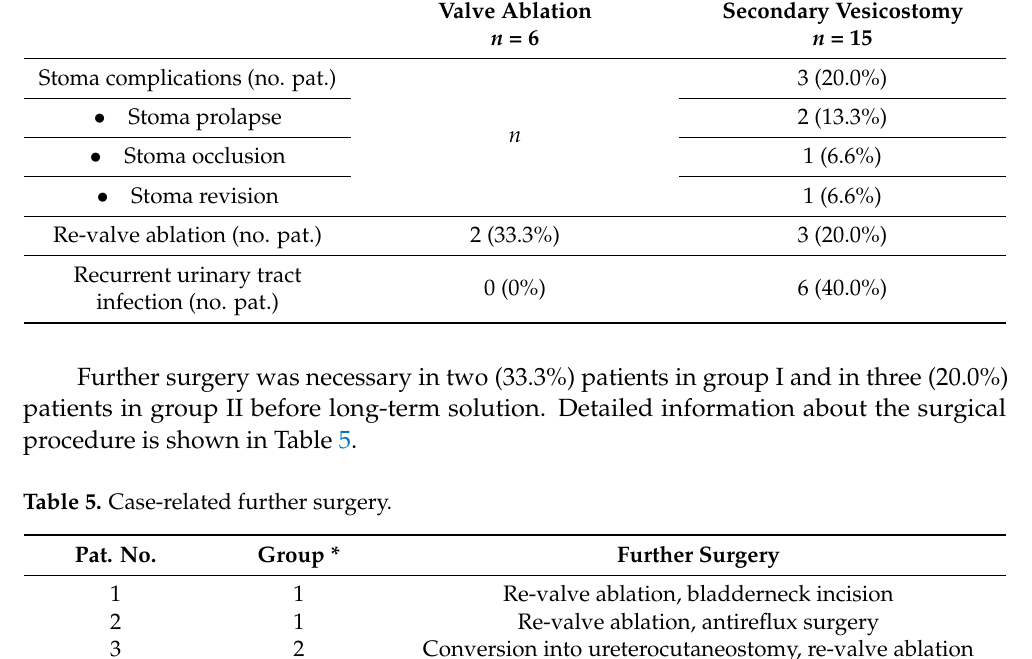
Secondary Vesicostomy n = 15 3 (20.0%)